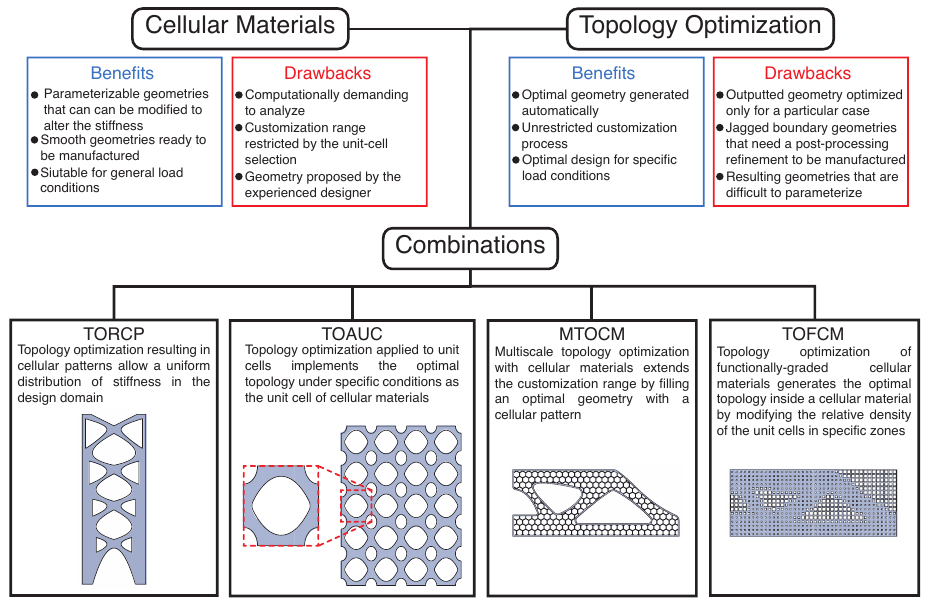
Figure 18. Summary diagram of the Cellular Materials and Topology Optimization approaches and their